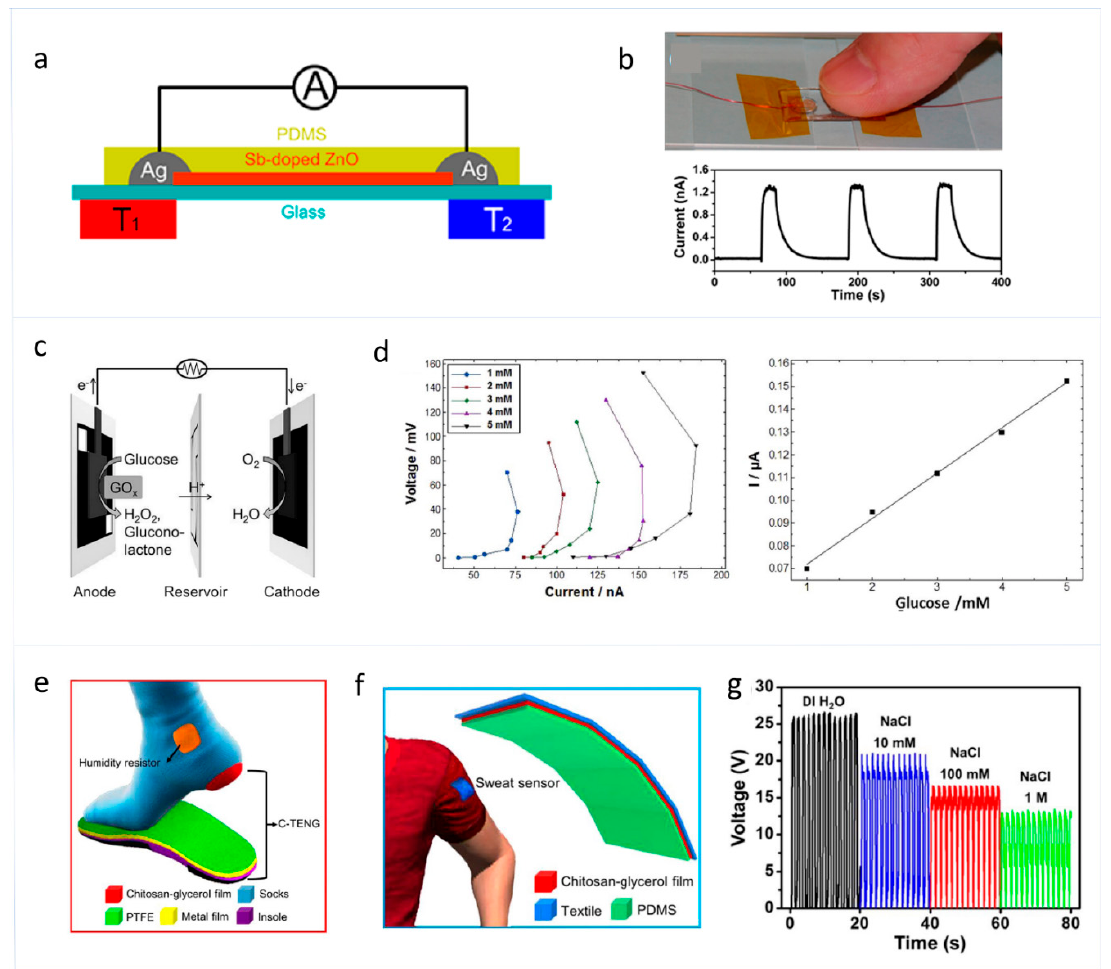
Figure 7. ( a ) Schematic diagram of a single Sb-doped ZnO microbelt nanogenerator. ( b ) Optical image showing a finger touching an electrode of the nanogenerator and its corresponding output current [46]. Copyright 2012, American Chemical Society. ( c ) Schematic illustration of the structure of the biofuel cell. ( d ) Diagrams of polarization curves with different concentrations of glucose, and calibration curve of output current versus the concentration of glucose in mM with a 1 M Ω resistor connecting the device’s electrical leads [47]. Copyright 2018, Elsevier. ( e ) The schematic illustration of the TENG connected on socks. ( f ) Schematic structure of the self-powered sweat sensor on commercial fabrics. ( g ) Output voltage of the sweat sensor when detecting clothes adsorbed with NaCl solution with various concentrations [48]. Copyright 2018, Elsevier.